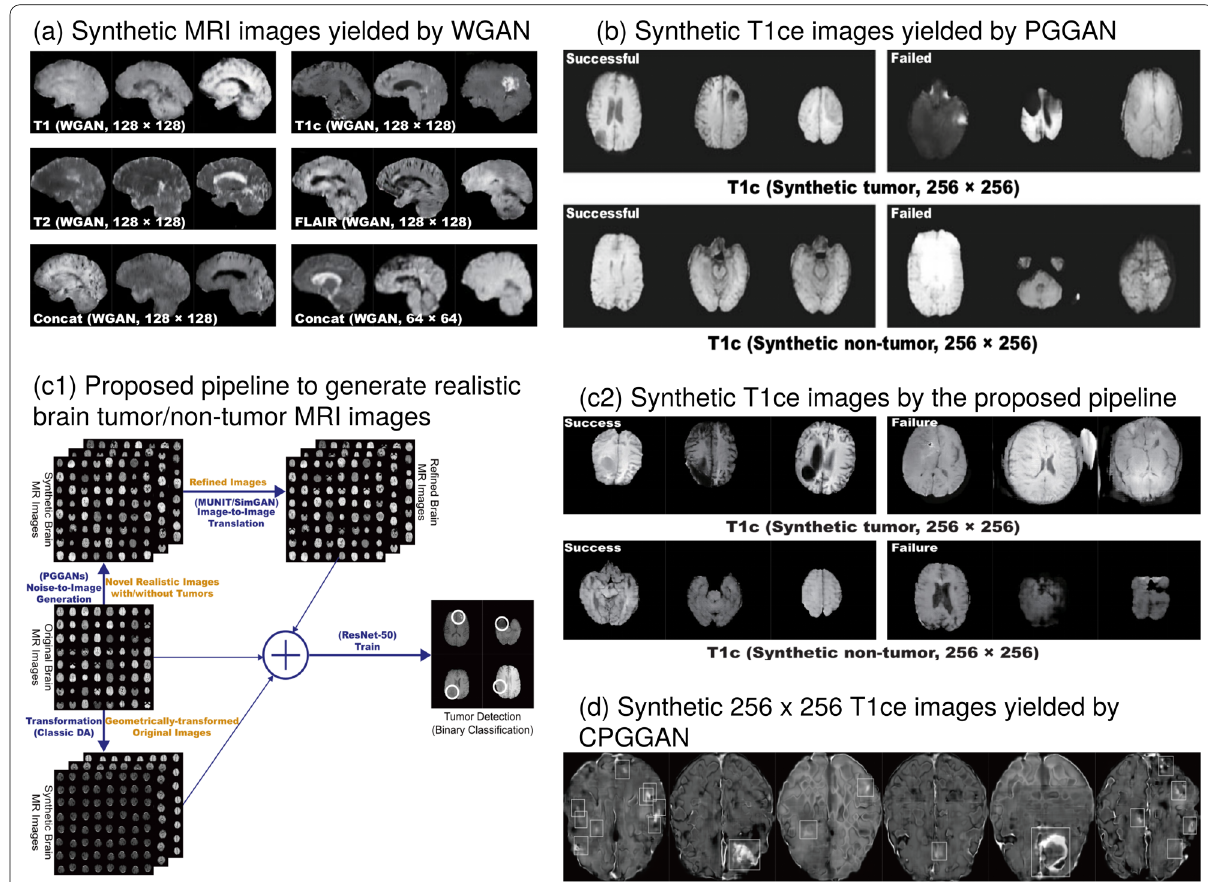
Fig. 8 Key findings and a proposed pipeline by the examined studies. a Depicts the synthetic samples in each MRI sequence [39]. b Example of T1 contrast-enhanced synthetic tumor and normal examinations in both successful and failed cases [41]. c1 The proposed noise-to-image and image-to-image combined architectures for tumor detection [42]. c2 Example of T1 contrast-enhanced synthetic tumor and normal examinations in both successful and failed cases [42]. d Synthetic T1 contrast-enhanced samples with the tumor bounding boxes [44]. By “non-tumor” areas